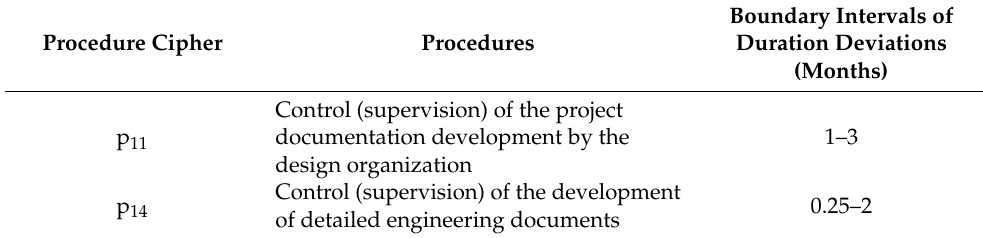
Table 2. Boundary intervals of deviations from the standard duration of design